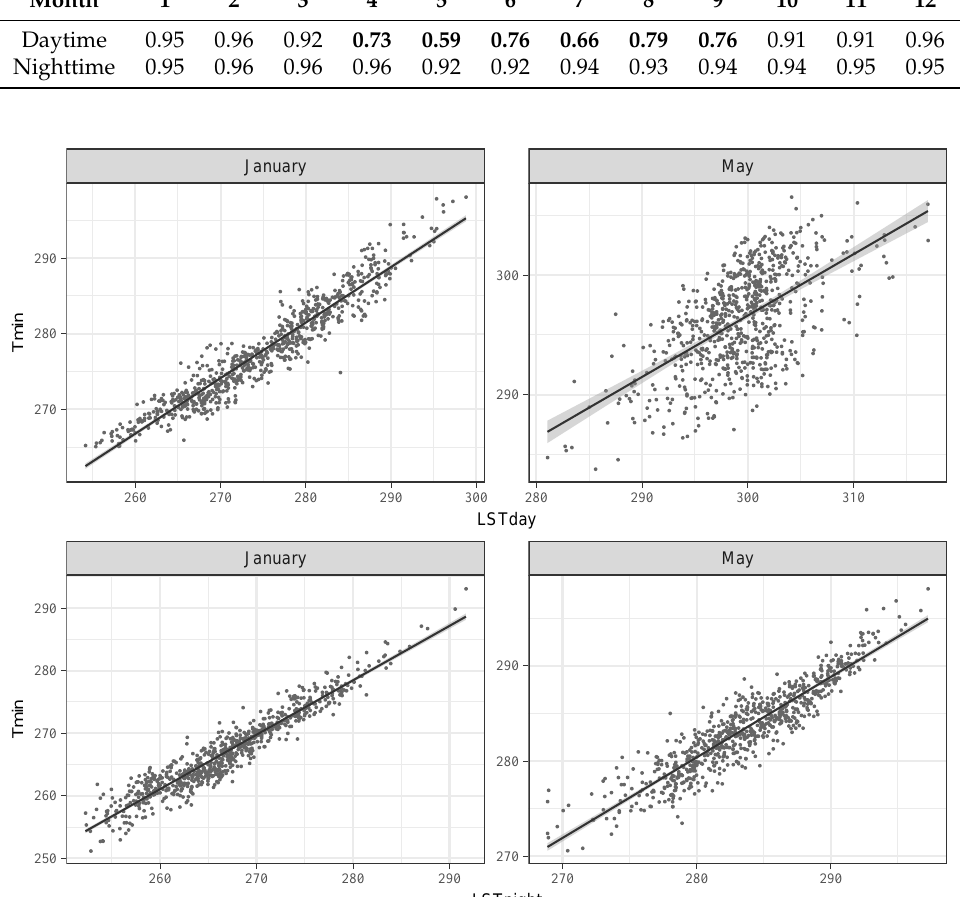
Figure 3. Scatter plots between surface air temperature (Ta) and land surface temperature (LST) for two selected months: ( top row ) plots of maximum temperature (Tmax) against LSTday. ( bottom row ) Plots of minimum temperature (Tmin) against